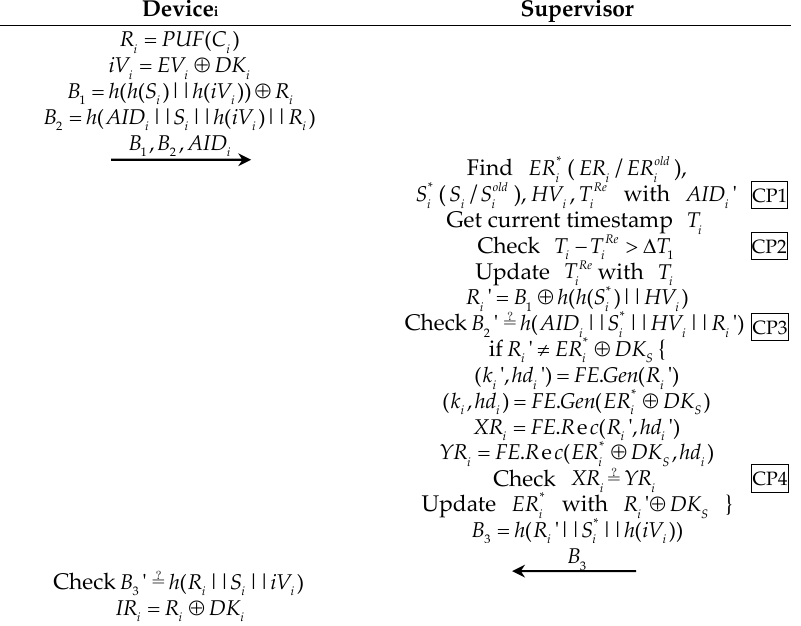
Figure 3. PEASE protocol steps in the initialization phase. (CP1-4 stand for checkpoints for attack detection; this will be described in Section 4.2).